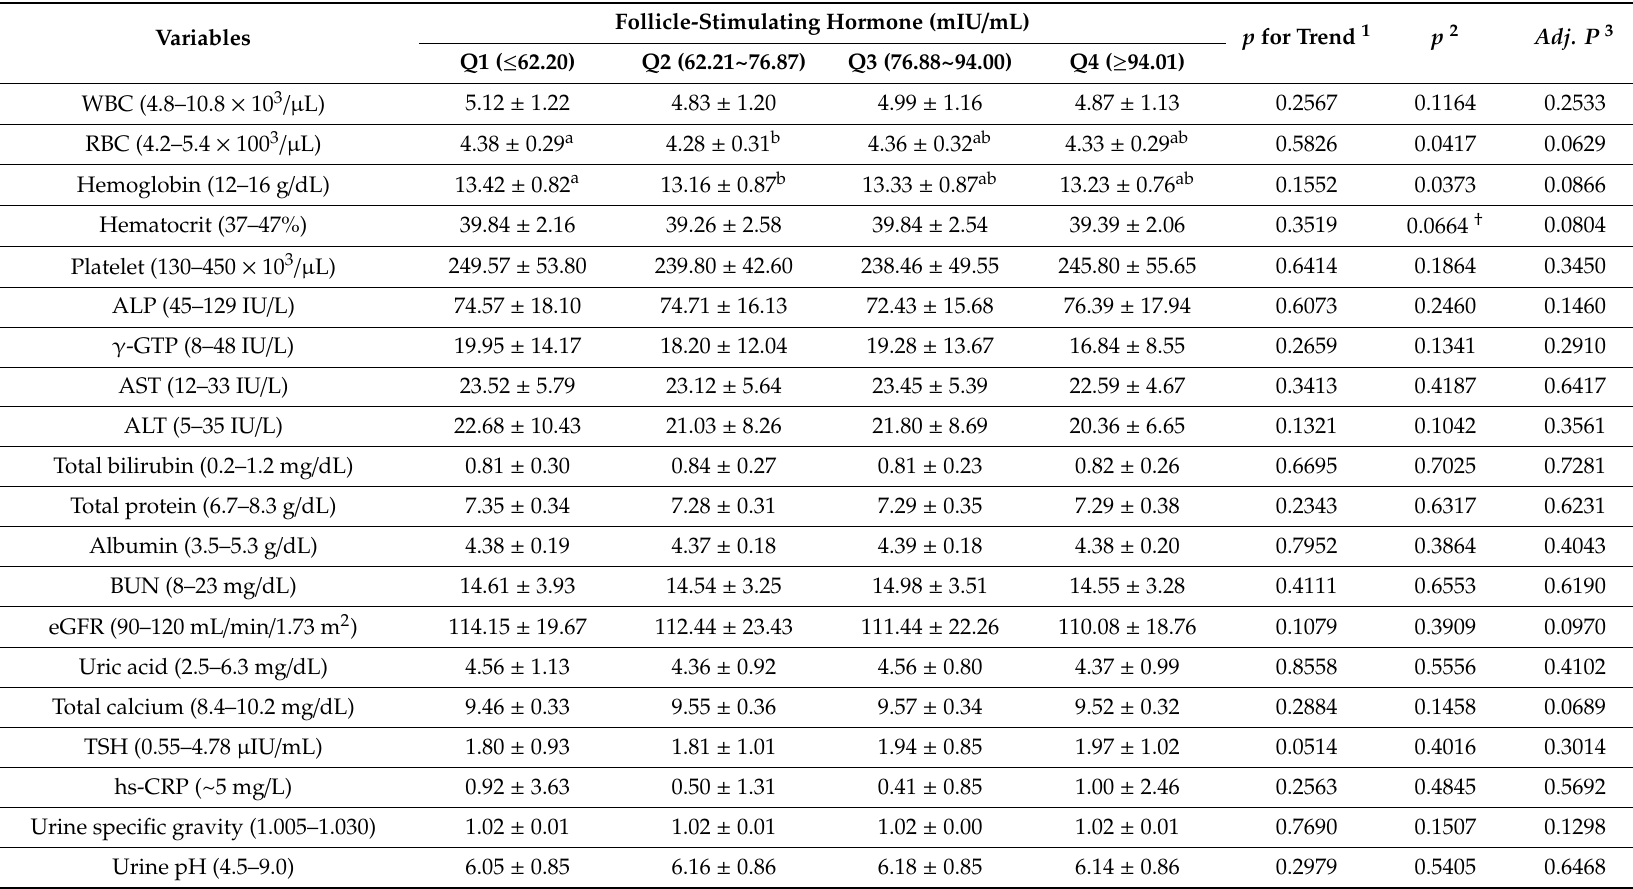
Table 2. Comparison of laboratory characteristics by quartiles of follicle-stimulating